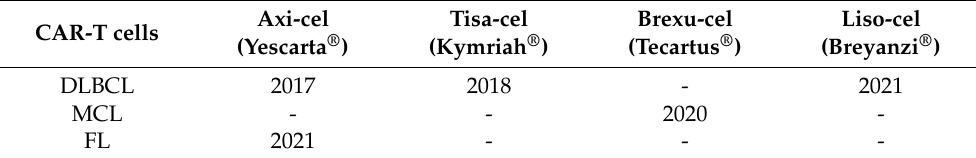
(Table 1). No TCE have yet been approved for the treatment of B-cell lymphomas. Table 1. CAR T-cells Currently approved by the FDA for the Treatment of B-cell Lymphoma. Axi-cel CAR-T cells (Yescarta ® )